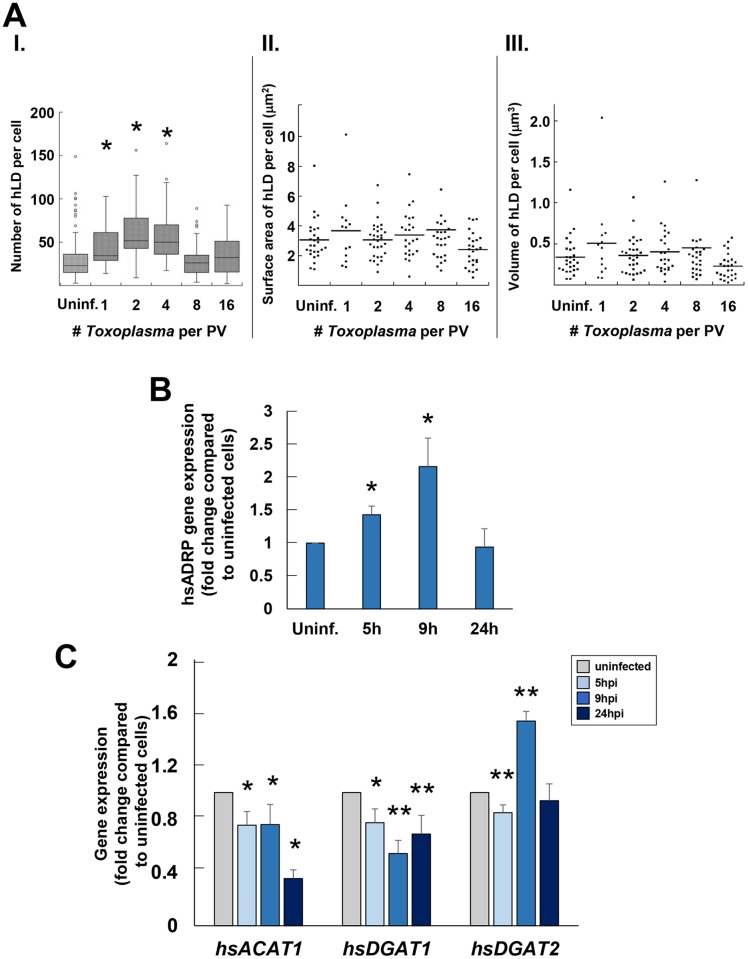
Influence of Toxoplasma infection on host LD number and composition.A. Properties of host LD in infected HFF. Determination, using Volocity software, of the host LD (hLD) number (in I), surface area (in II) and volume (inIII) throughout infection. Data were acquired from 2 independent experiments, and were categorized by the number of parasites per PV (> 30 PV counted per experiment for each sample). In panels II and III, the values of host LD surface area and volume, expressed in μm2 and μm3 respectively, represent the mean surface area and volume of host LD in individual cells, grouped together (n < 30 cells per replicate experiment), of which there were no statistical differences. Significant differences were observed for host LD number, which increased in cells containing PV with a single, 2 and 4 parasites, as compared to uninfected cells (*p <0.05). B. Human Adipose Differentiation-Related Protein (hsADRP) gene expression in infected HFF. Real-time PCR analysis of hsADRP transcripts throughout infection. Data are means ± SD of 3 separate assays performed in biological triplicates, showing significant increase of transcript levels of hsADRP at early time points of infection compared to uninfected cells (p <0.001) C. Human Acetyl-Coenzyme A Acetyltransferase 1 (hsACAT1), Diacylglycerol O-Acyltransferase 1 (hsDGAT1) and Diacylglycerol O-Acyltransferase 2 (hsDGAT2) gene expression in infected HFF. Real-time PCR analysis of hsACAT1, hsDGAT1 and hsDGAT2 throughout Toxoplasma infection. Data are means ± SD of 3 separate assays performed with biological triplicates, showing significant changes in transcript levels of the three genes early in infection compared to uninfected cells (*p <0.0003; **p <0.0001).